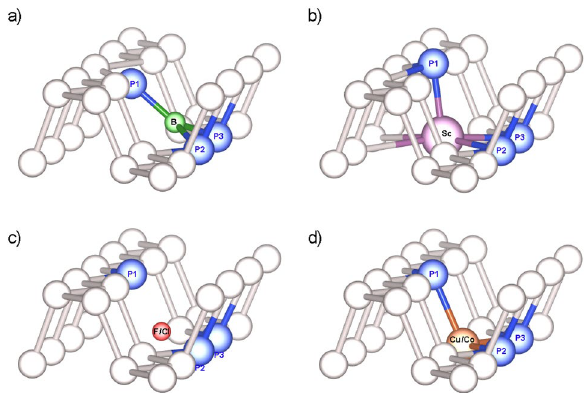
Figure 2. Structural deformation of the ( a ) B, ( b ) Sc, ( c ) F/Cl ( d ) Cu/Co-doped phosphorene lattice.